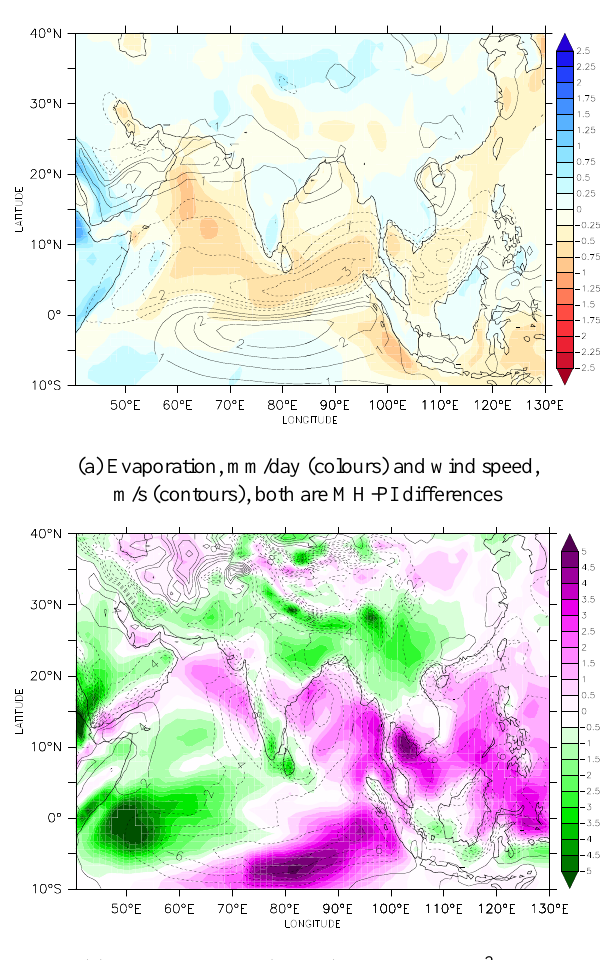
(a) Evaporation, mm/day (colours) and wind speed, m/s (contours), (b) Vertical velocity (omega) at 500hPa, hPa/s (b) Vertical velocity (omega) at 500hPa, 10 − 2 Pa/s Fig. 11. MH-PI JAS differences in (a) evaporation (colours, Fig. 11. MH - PI JAS differences in (a) evaporation (colours, mm/day) and wind speed (contours, m/s), (b) vertical velocity at 500hPa in mmday − 1 ) and wind speed (contours, ms − 1 ), (b) vertical veloc- hPa/s (negative values indicating upward motion), contours are PI values. 500 hPa is approximately 500 km. ity at 500hPa in 10 − 2 Pas − 1 (negative values indicating upward motion), contours are PI values. 500hPa is approximately 5km.